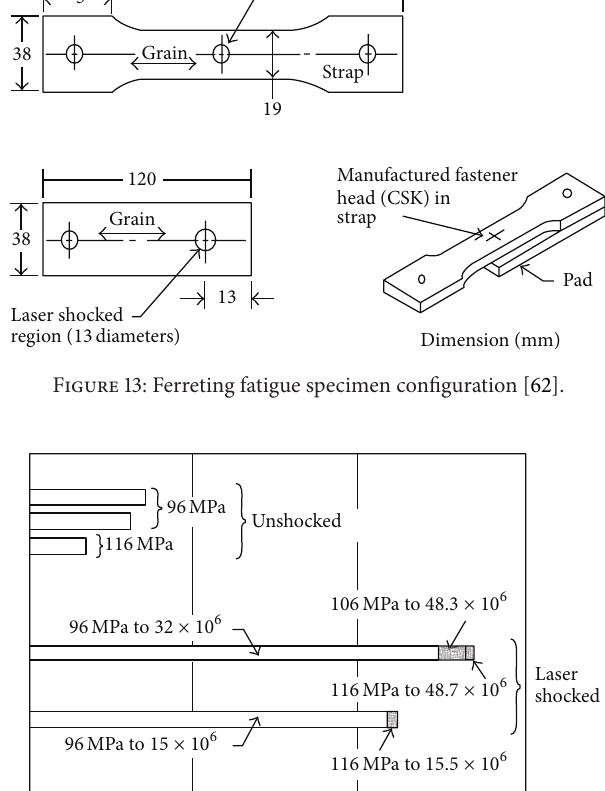
greater fatigue resistance promotion is noted after laser shock